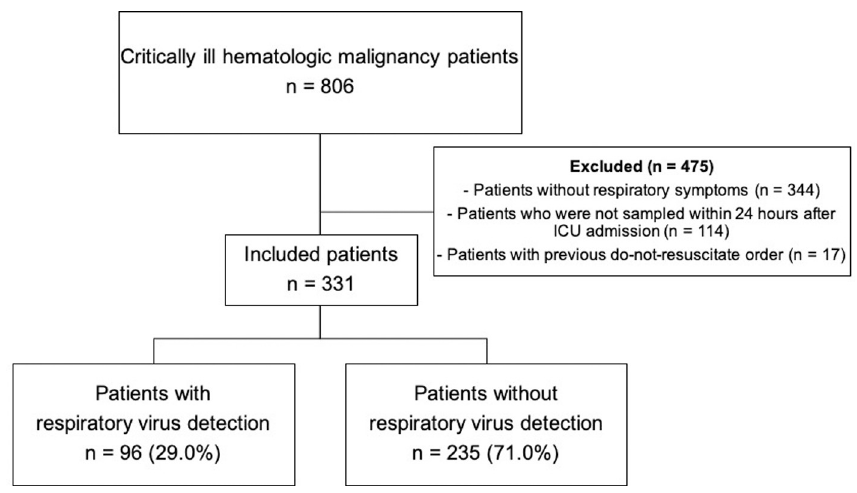
Fig 1. Study flow diagram. ICU, intensive care